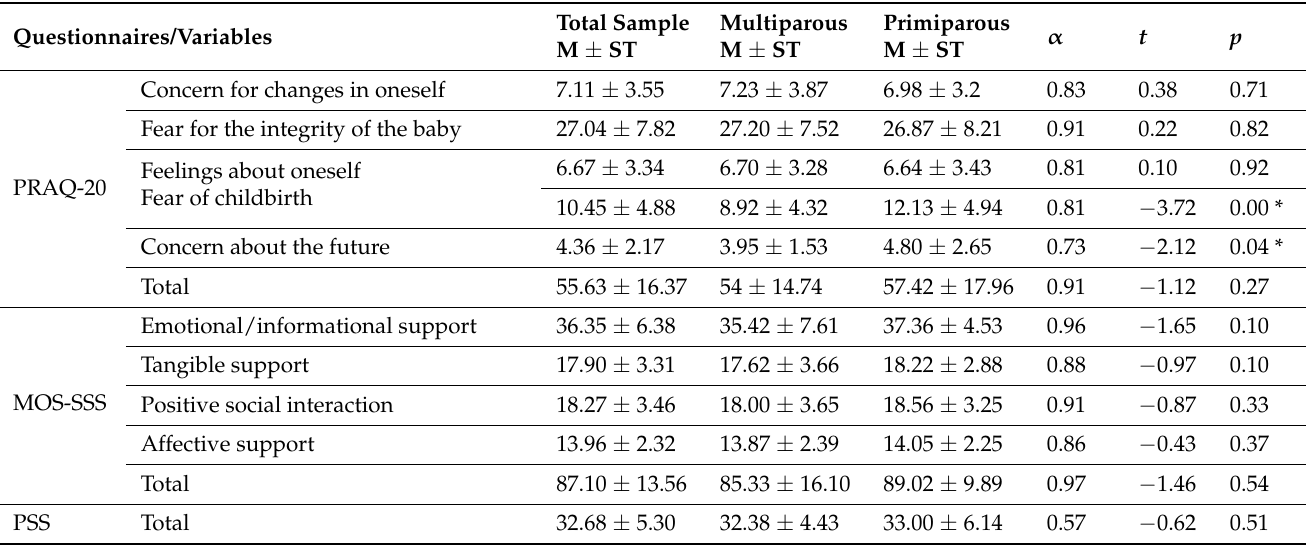
Table 2. Descriptive statistics of anxiety, social support, and stress of the simple and difference in means by gravity.